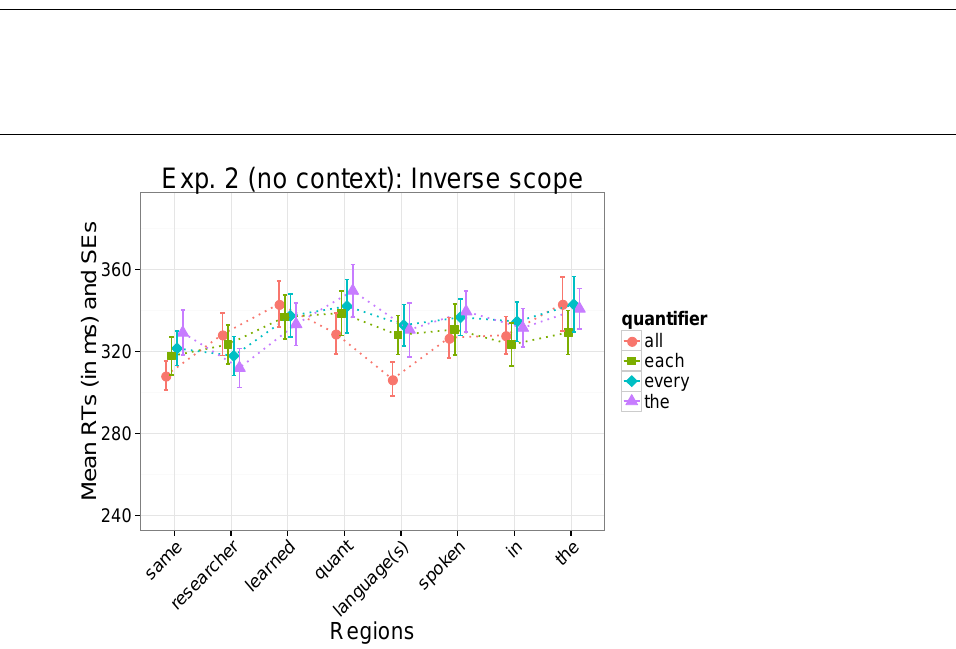
Figure 8 Mean RTs and SEs for all ROIs in Experiment 2 (no context); inverse scope only.